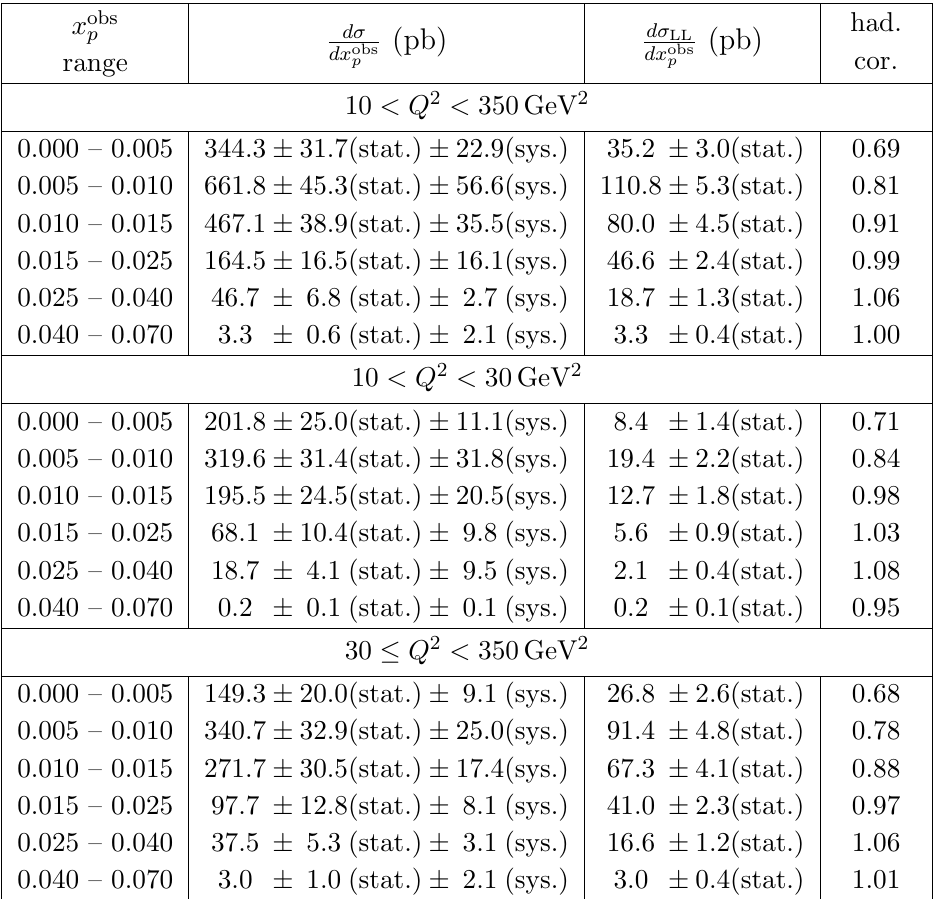
Table 2 . Measured di(cid:11)erential cross-section d(cid:27)